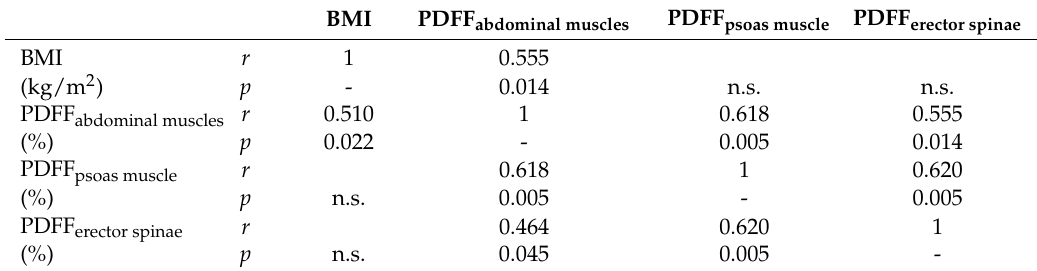
Table 6. Partial correlations for men with age as a control variable.